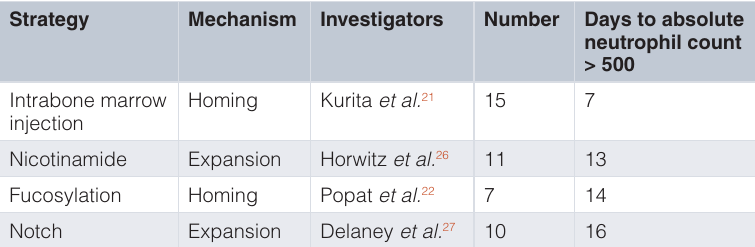
Table 1. Novel strategies to improve